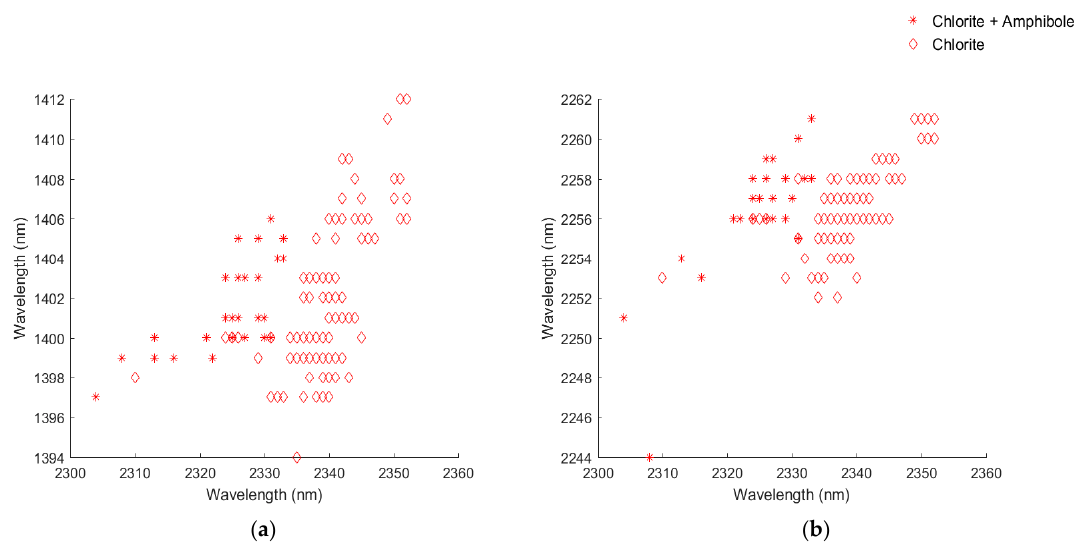
Figure 8. Comparison of the characteristic absorption features of chlorite and the influence of amphibole minerals. ( a ) Mg-OH absorption wavelength against the -OH absorption wavelength ( b ) Mg-OH absorption wavelength against Fe-OH absorption wavelength.